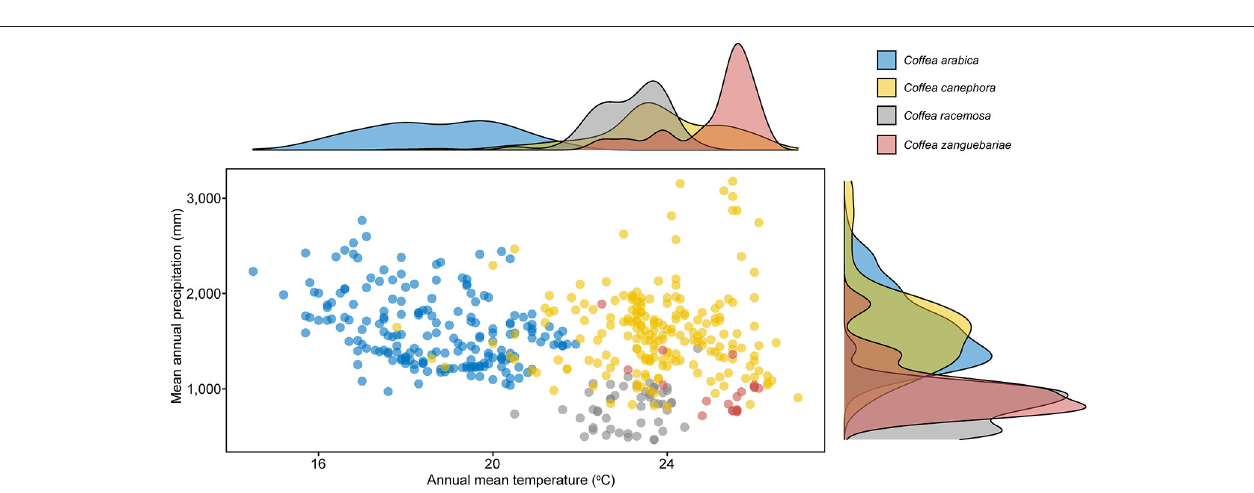
conversion), when using the wet processing method. The mean loss from fresh cherry to pulped coffee (i.e., with the fleshy part removed) is 59.1%; the mean loss from pulped coffee to parchment is 63.9%; and the mean loss from parchment to green is